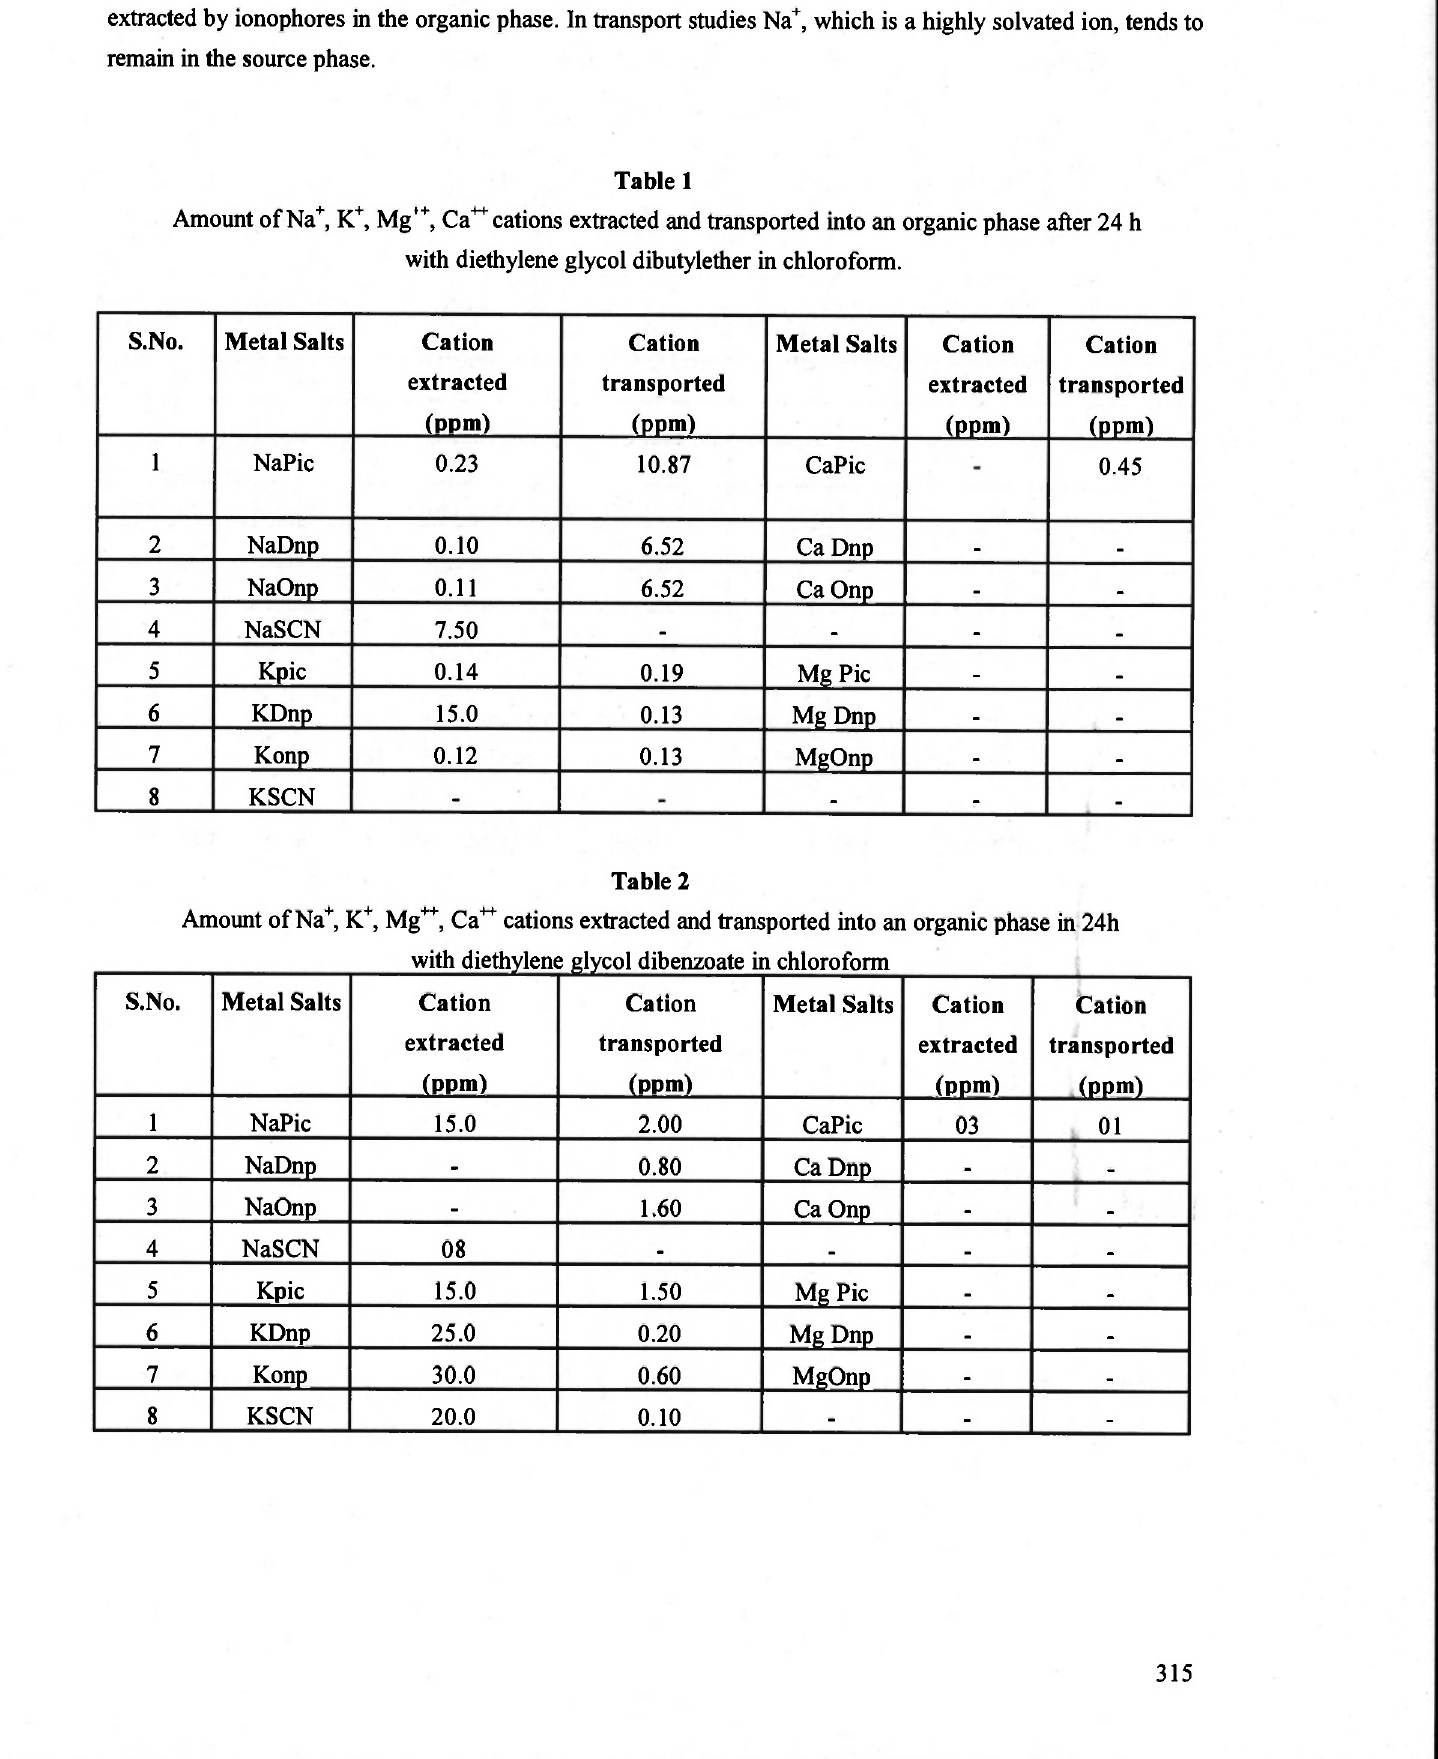
Amount of Na + , K + , Mg' + , Caseations extracted and transported into an organic phase after 24 h with diethylene glycol dibutylether in chloroform.